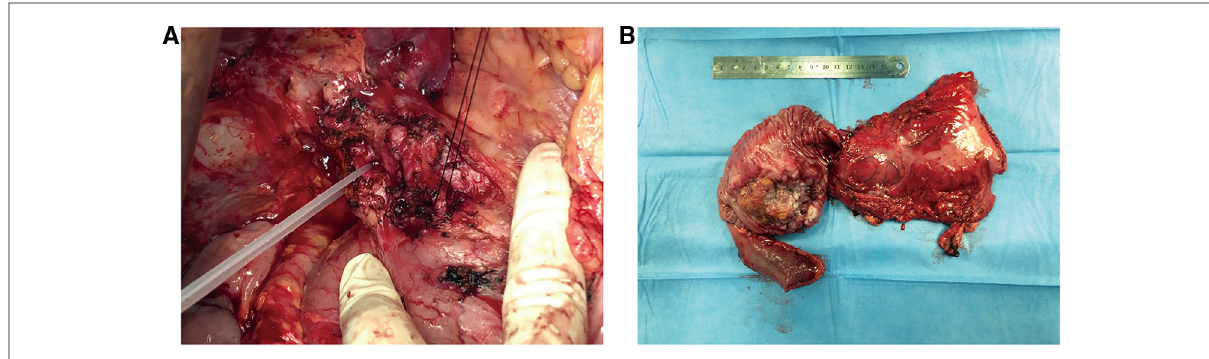
FIGURE 2 ( A ) intraoperative anatomy of the donor liver ’ s artery and gastroduodenal artery. ( B ) By gross appearance, the resected specimen shows a tumor with ulceration measuring 6.5×5×5 cm.